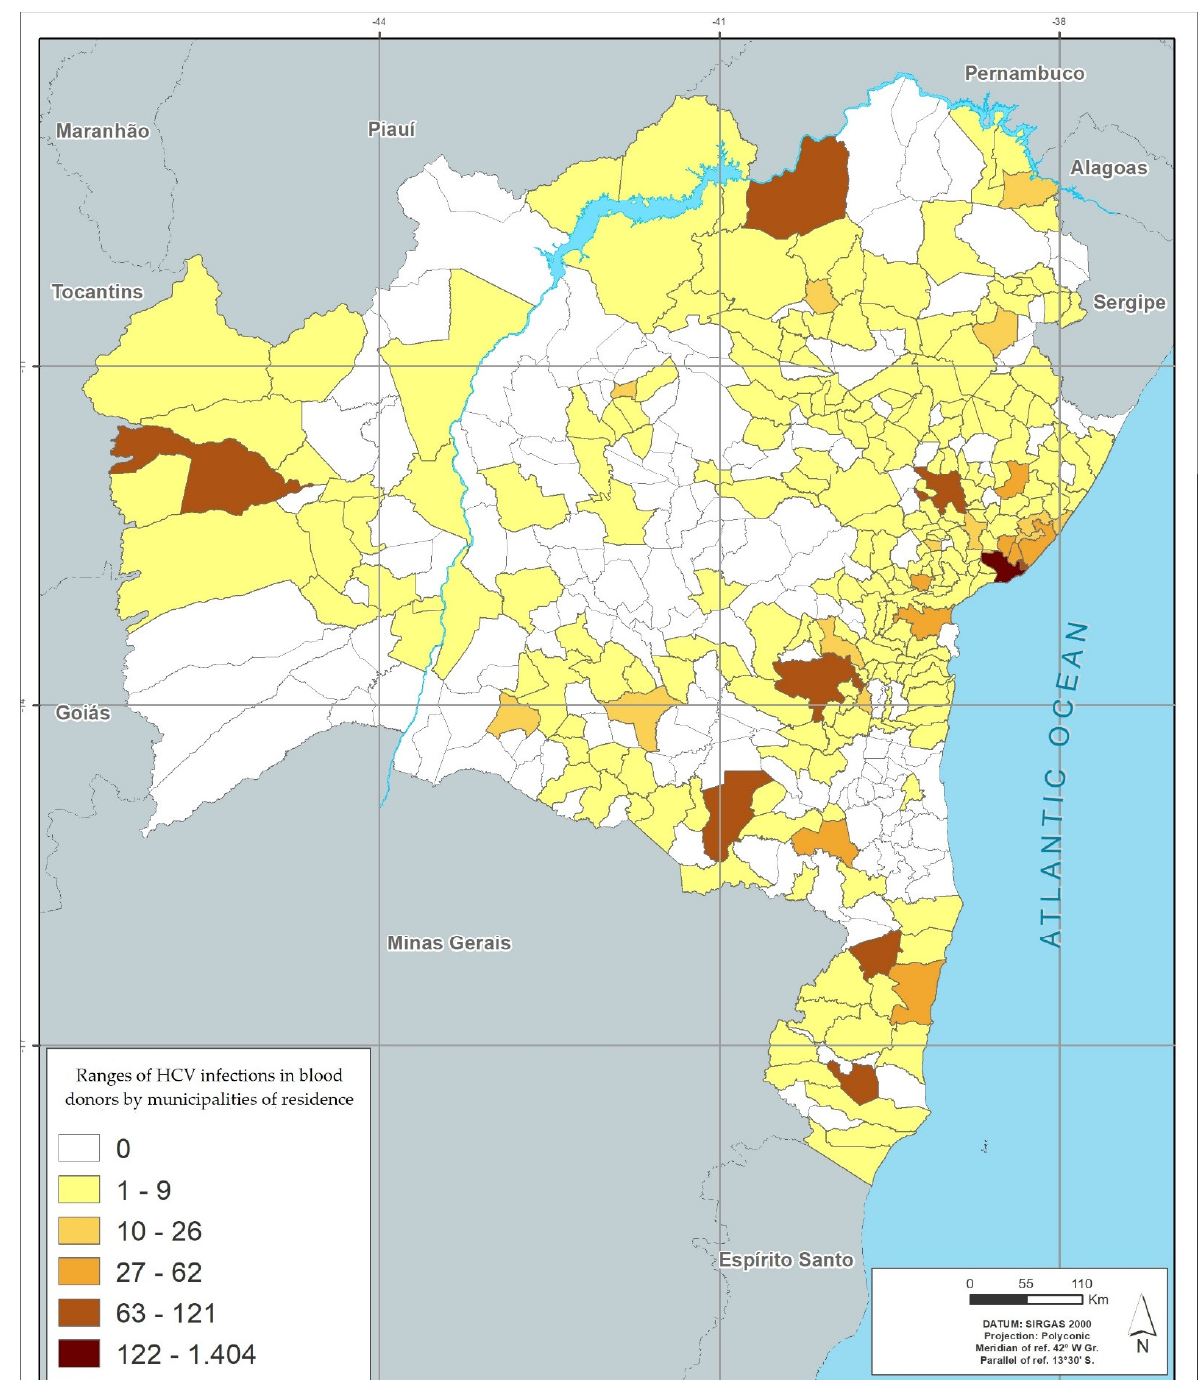
Figure 3. Infection’s rates in absolute numbers for HCV by municipalities of residence in blood donors between 2008-2017.